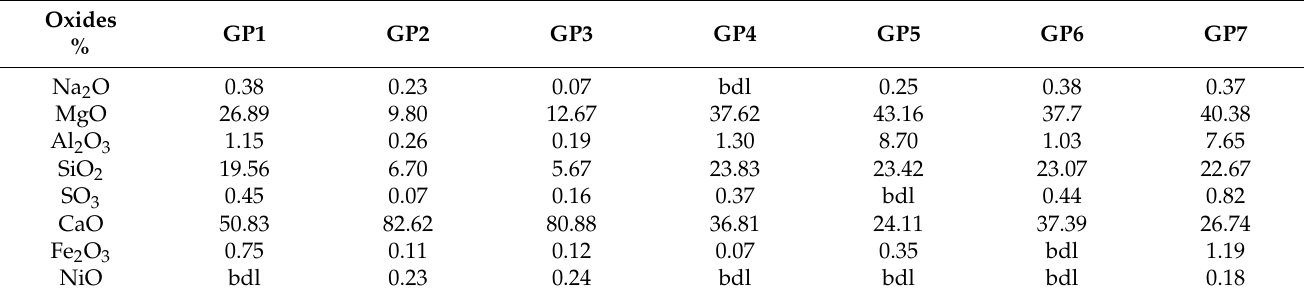
Table 3. Microchemical spot analyses (GP1–GP7) of high birefringence and dark areas of air hardening magnesian lime of Figure 4.